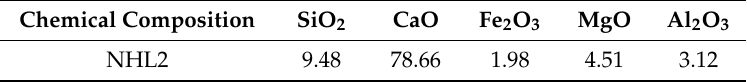
Table 1. Chemical composition of NHL2 (wt